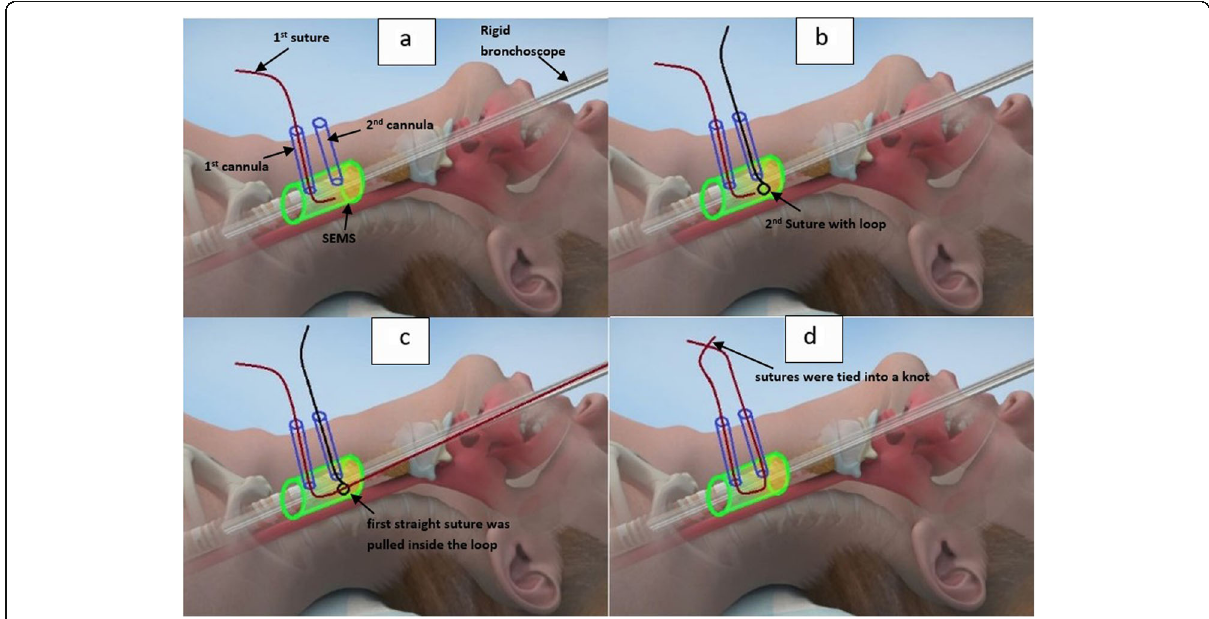
Fig. 3 Labeled animated representation of steps of double hitch stitch